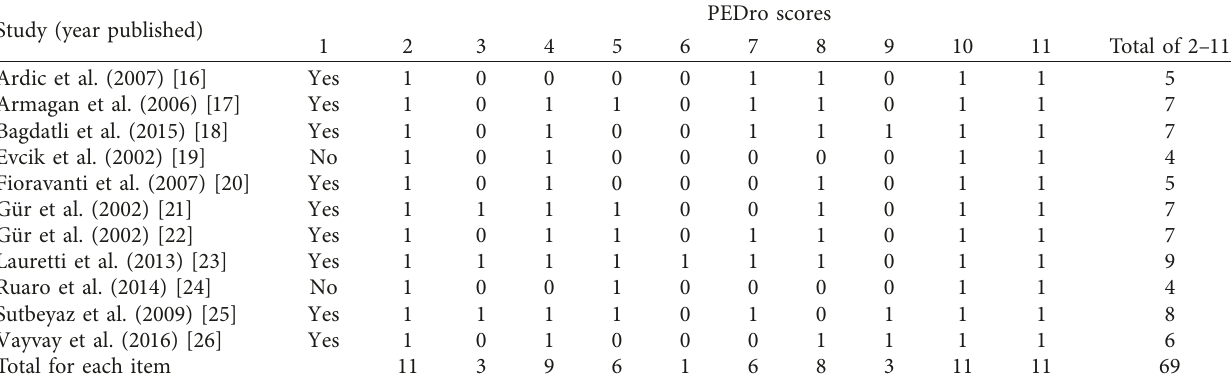
Figure 1: The different phases of the search of the three databases and the selection of the studies included in the present Table 1: Detailed description of PEDro scores.